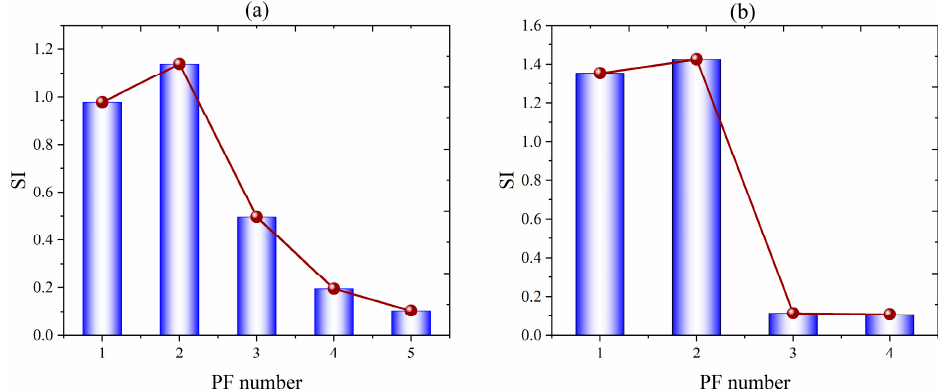
Figure 14. The SI value for each PF was calculated by processing the outer race fault signal at 2100 r/min: ( a ) RLMD and ( b ) CCERLMDAN.